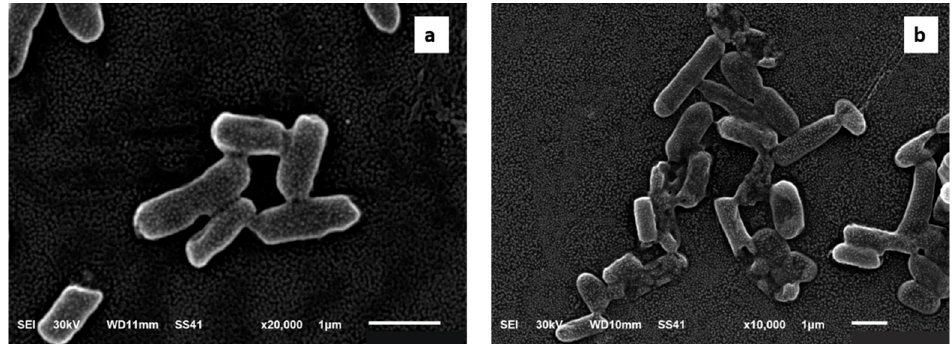
Figure 7. Scanning electron microscope image of a representative K. pneumoniae isolates ( a ) before and ( b ) after treatment with C. thouarsii extract (16 µ